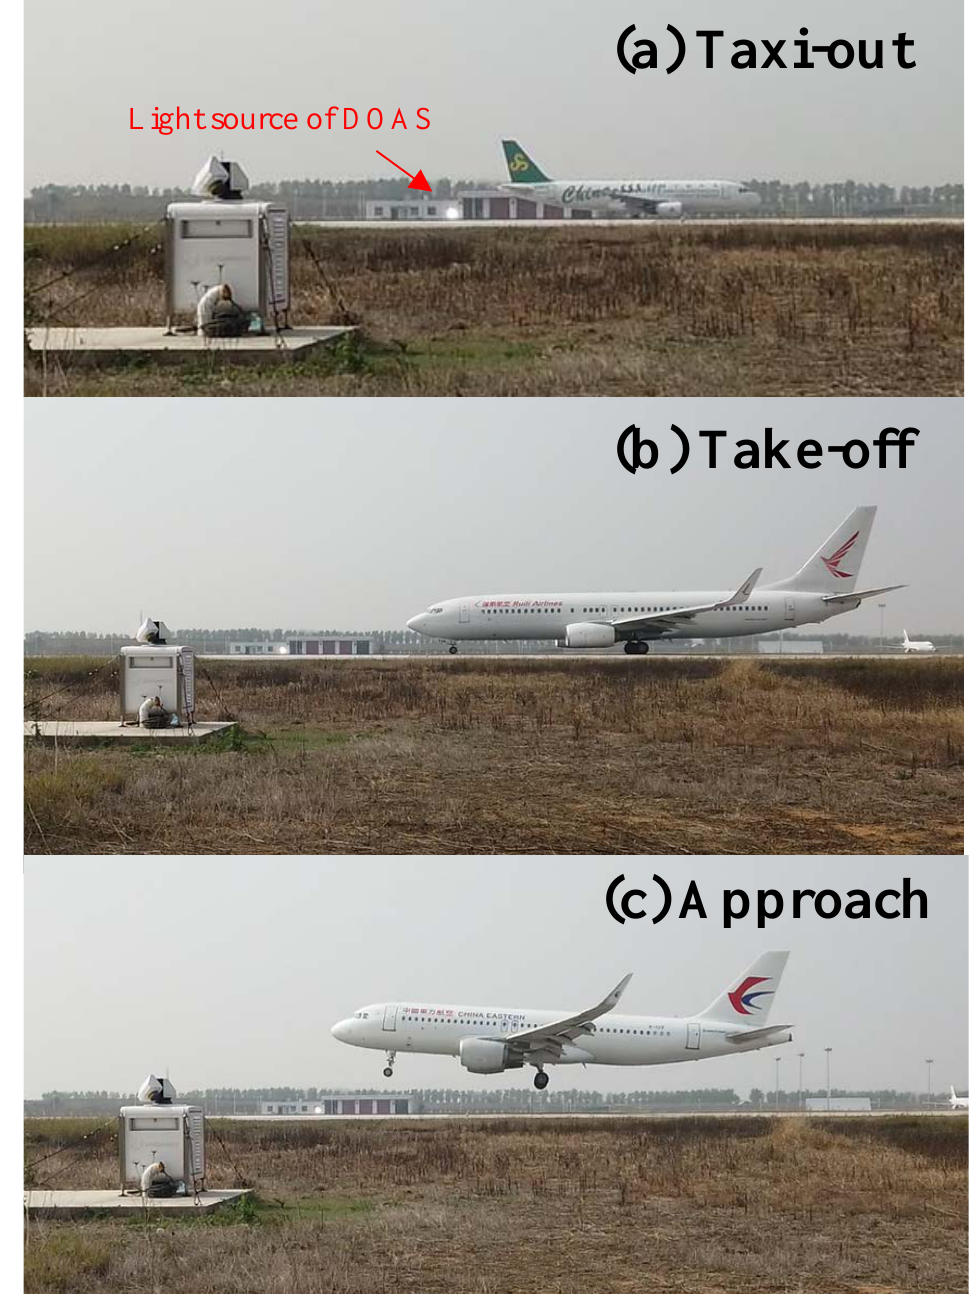
Figure 3. Photographs of the measurement field. These photographs were captured in front of the retroreflectors array (the location was at point B in Figure 2b).